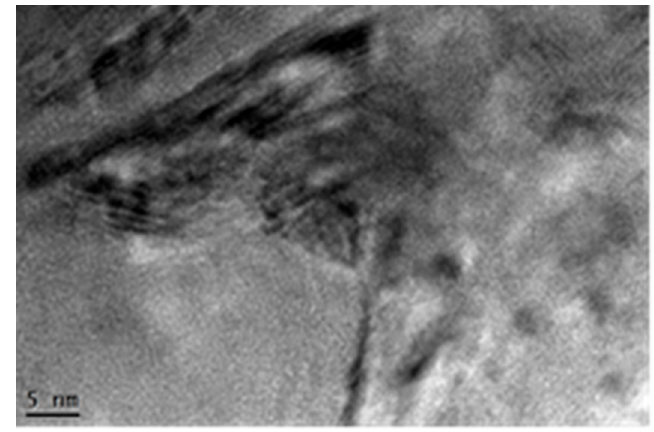
Figure 8. HRTEM image in the top surface layer of GH3039 superalloy after LSP.